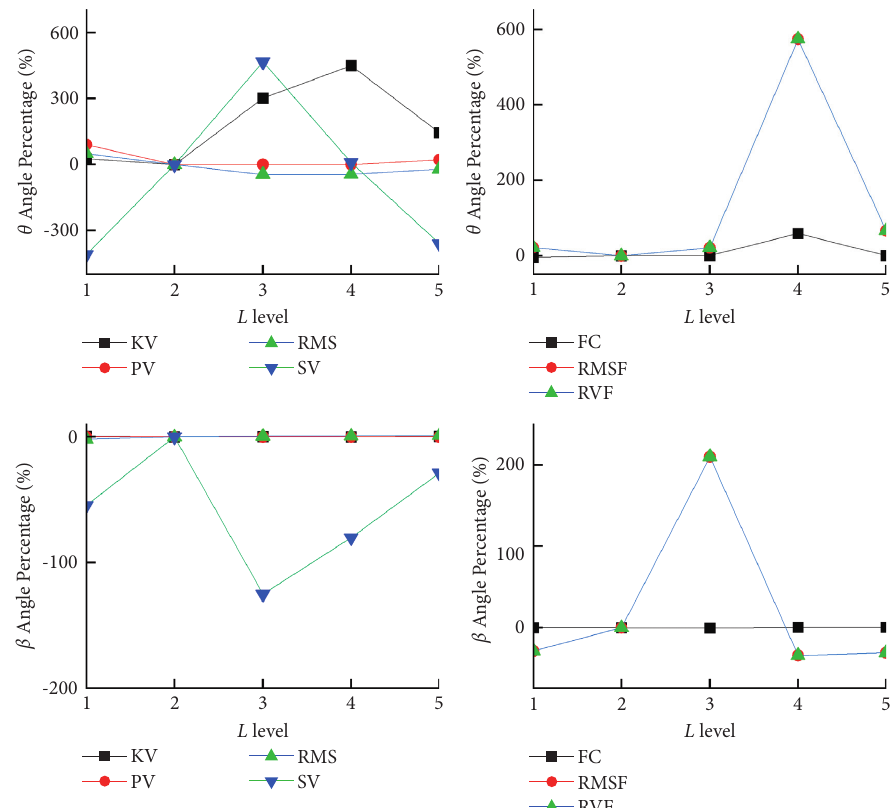
Figure 10: Effect of the rope length on the lift-luffing